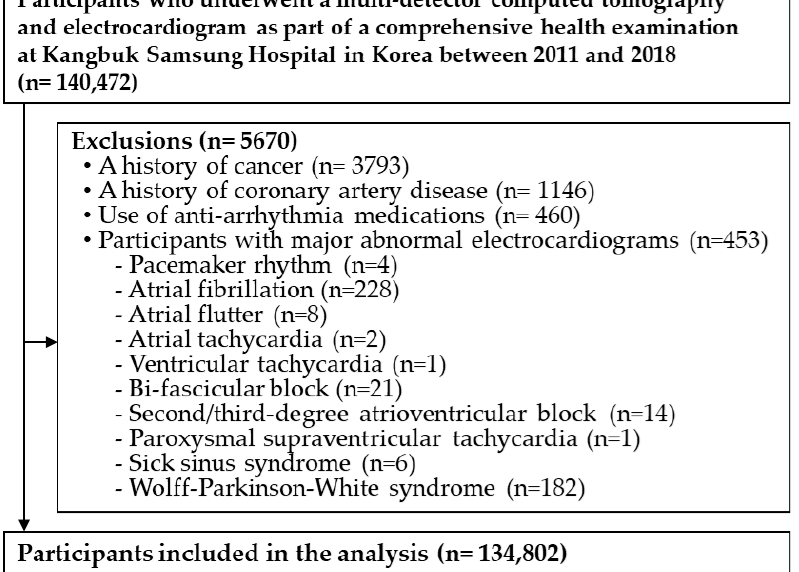
Figure 1. Flow chart describing the selection of the study